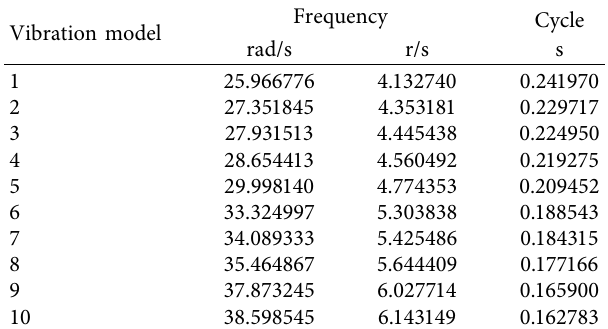
Table 3: Natural frequency and mode shape of slope dynamic